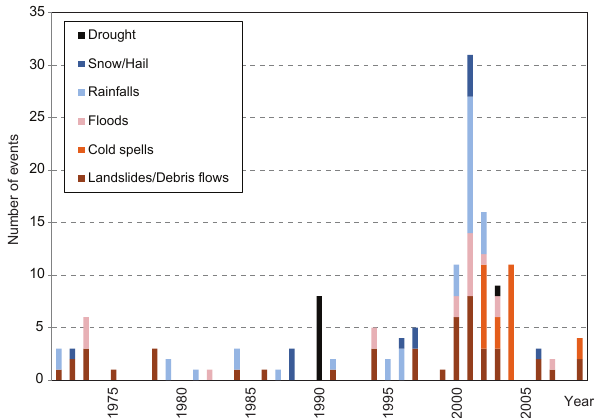
Figure 5. Number of climatic disasters in the region of Apurímac and distribution according to type of event